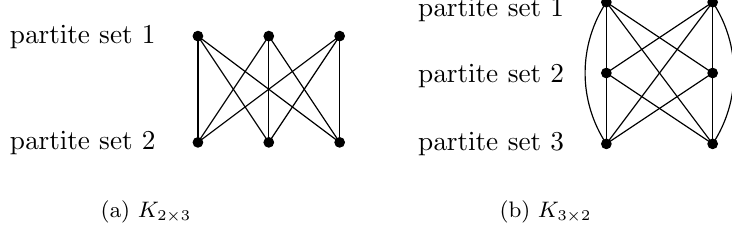
Figure 1: Graphical representations of two complete balanced multipartite